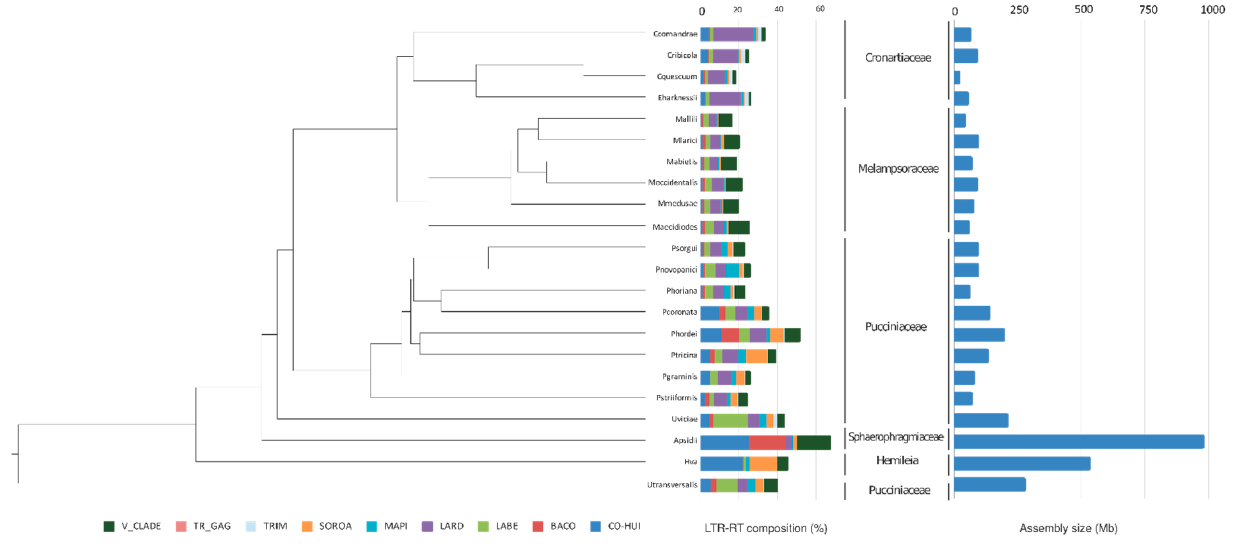
Figure 6. Contribution of LTR-RTs to the genome size of the Pucciniales species. The species were ordered according to their phylogenetic relationships using a tree constructed with BUSCO genes. The length of the bars is proportional to the percentage of LTR-RT composition (indicated as percentages and the genome assembly size) and the size for each assembly is represented in Mb.